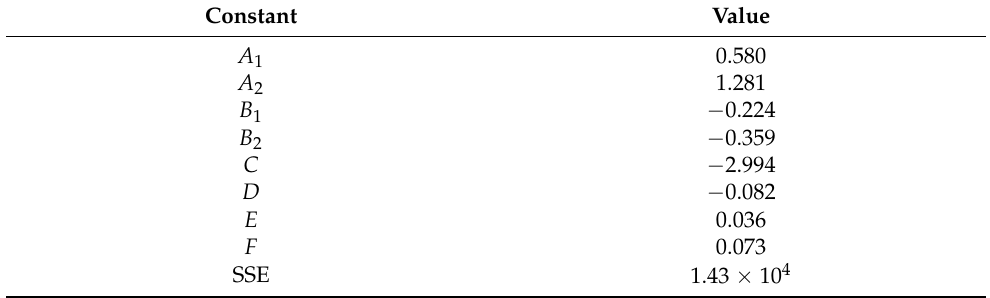
Table 3. Curve-fit constants for correlation of three-pad PM data (Equation (7)).